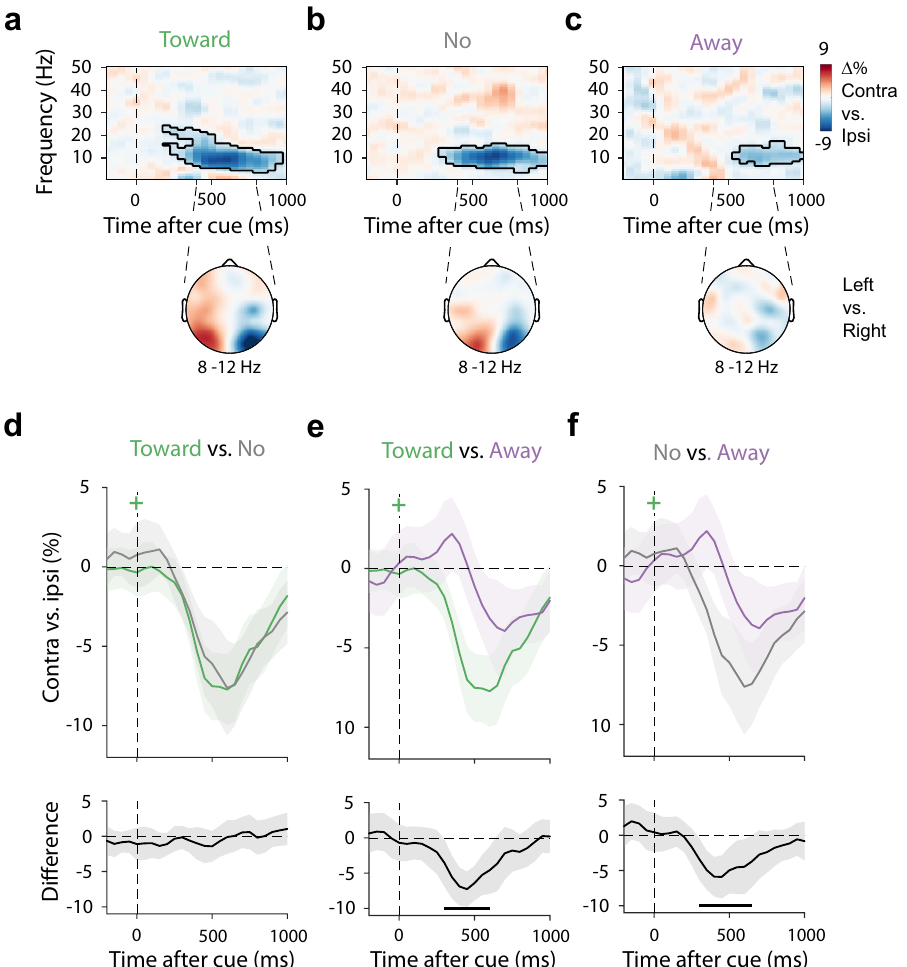
Fig. 3 Attention-directed microsaccades are correlated with, but not necessary for EEG-alpha modulation by covert spatial attention. a – c Neural lateralisation in visual electrodes relative to the memorised location of the memory item after the selection cue (top) together with the associated topographical map of the difference in 8 – 12 Hz alpha power in the 400 – 800 ms interval between trials in which to-be-reported memory item was left vs. right at encoding (bottom). This is shown separately for trials with a a toward microsaccade, b No microsaccade, or c an away microsaccade in the prede fi ned 200 – 600 ms selection period (Fig. 1d). Outlines indicate signi fi cant time-frequency clusters (two-sided cluster-based permutation test). d – f Overlays and comparisons of averaged 8 – 12 Hz alpha lateralisation. Black horizontal lines indicate signi fi cant temporal clusters (two-sided cluster- based permutation test). Time courses show mean values, with shading indicating 95% CI (calculated across 23